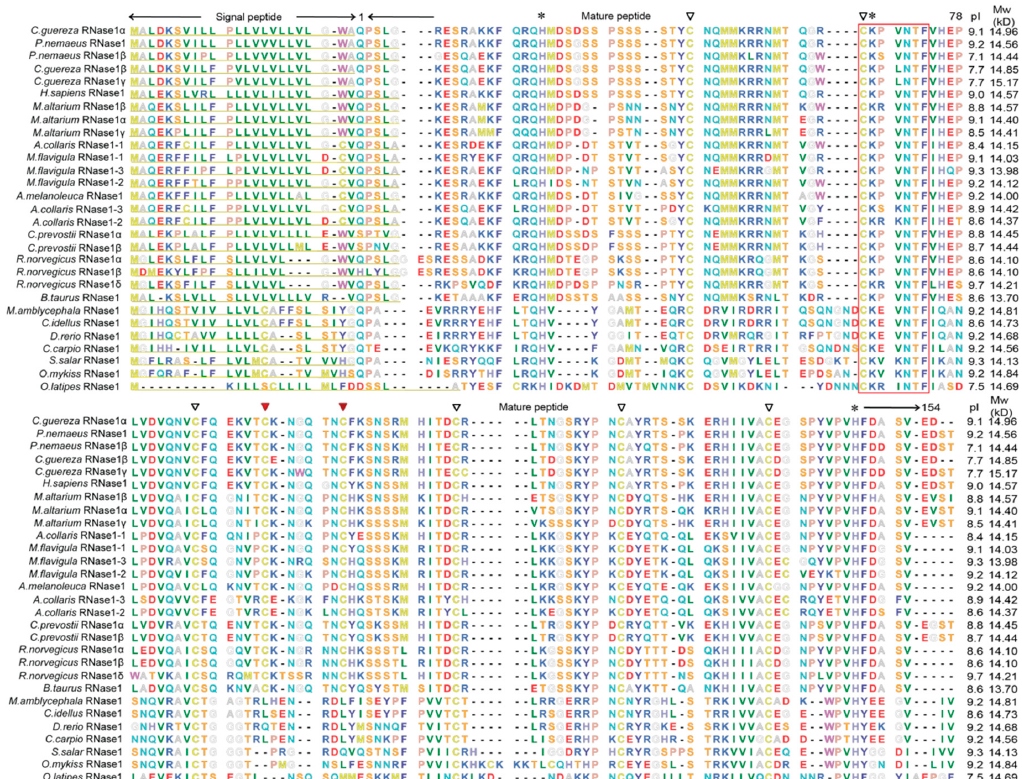
Figure 1. Multiple protein sequences alignment of RNase1 in fishes and mammals. Dashes indicate alignment gaps. Yellow underlines showed the signal peptides. The putative isoelectric point (pI) and molecular weight ( M w) indicated the isoelectric point and molecular weight (kDa) of the mature peptide, respectively. The conversed CKXXNTF motif is shown in a box. The eight structural cysteines (active-site residues) are marked with triangles and the two red triangles indicated alteration in fishes. Asterisks show the three catalytic resides.